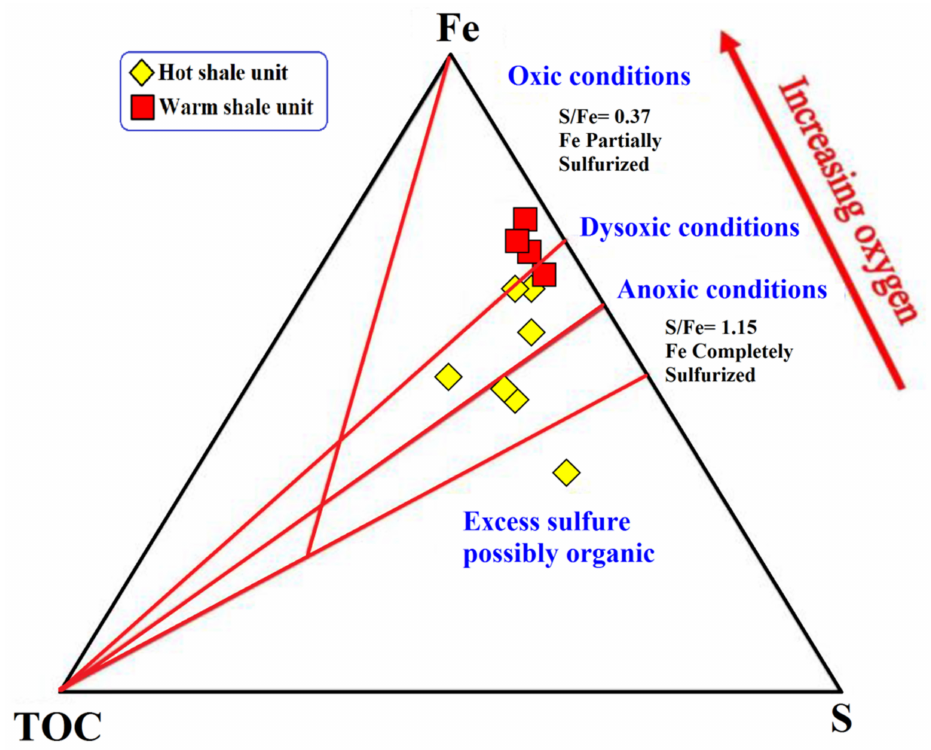
Figure 15. Ternary Fe 2 O 3 -TOC-S diagram of the analyzed shales of the Qusaiba units, showing dysoxic to anoxic environmental conditions during deposition of the Qusaiba shale